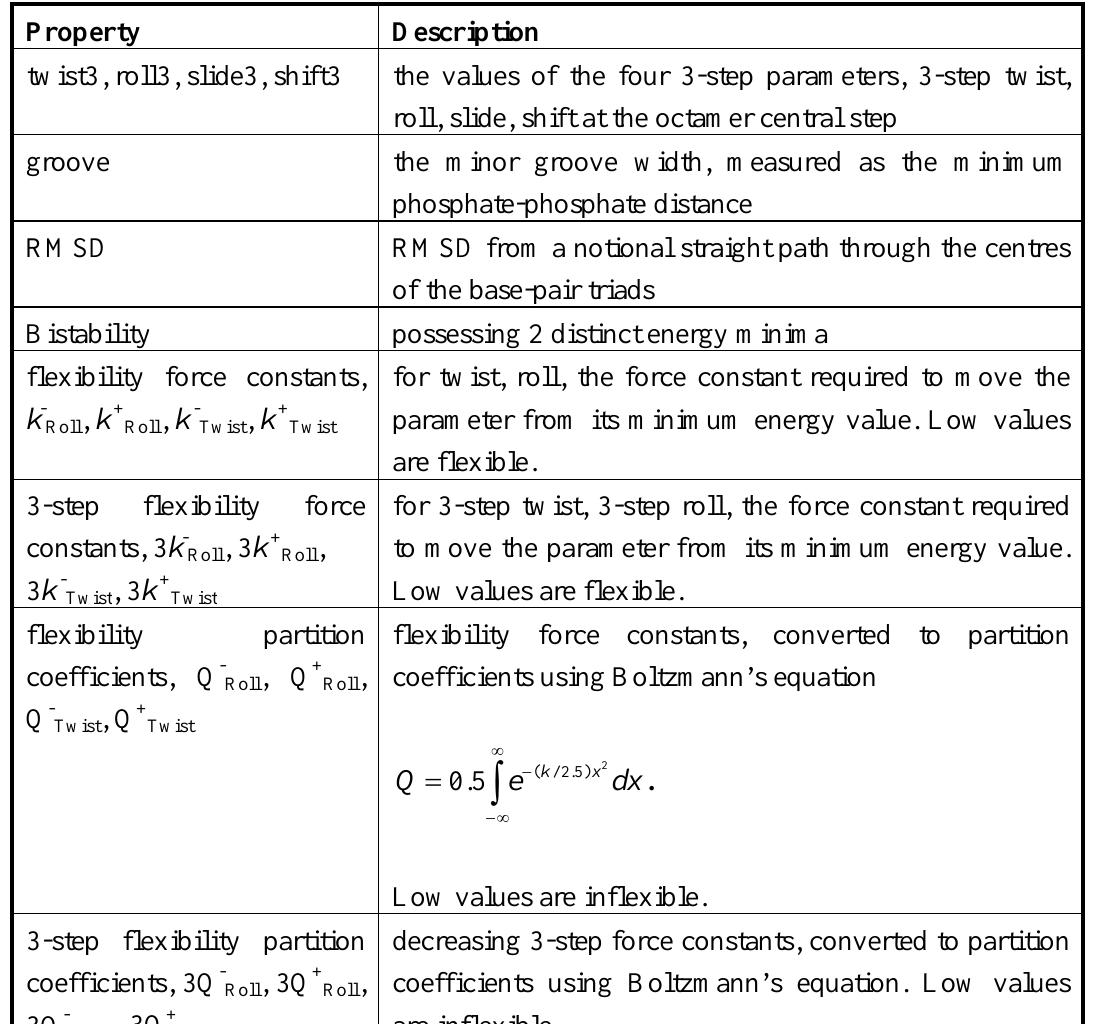
Table 1 . Octamer Structural